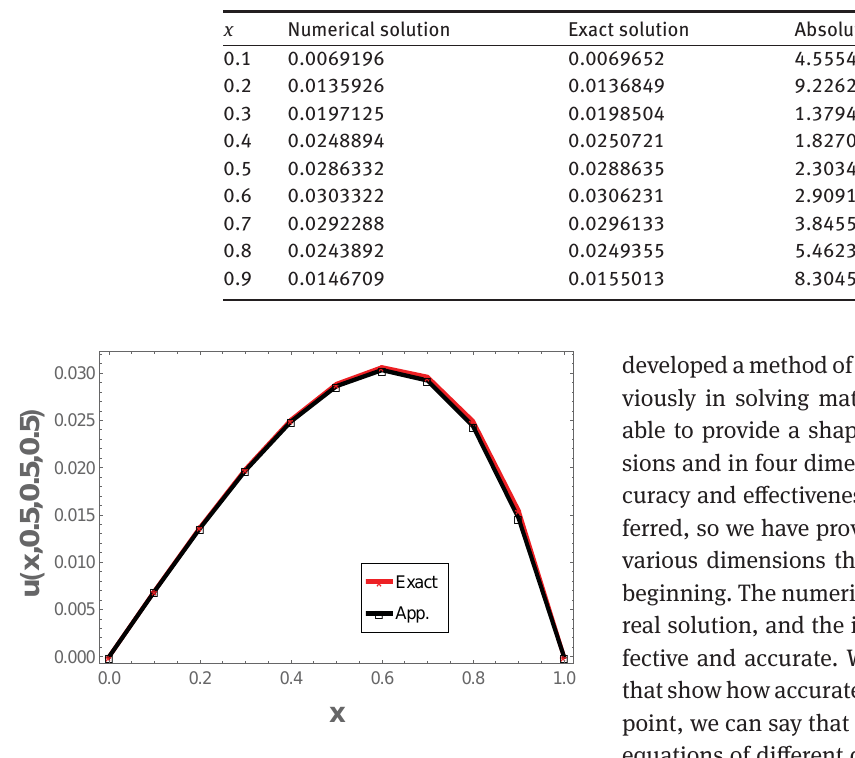
Figure 11: The numerical solutions with the exact solutions at y = z = d = 0.5 .